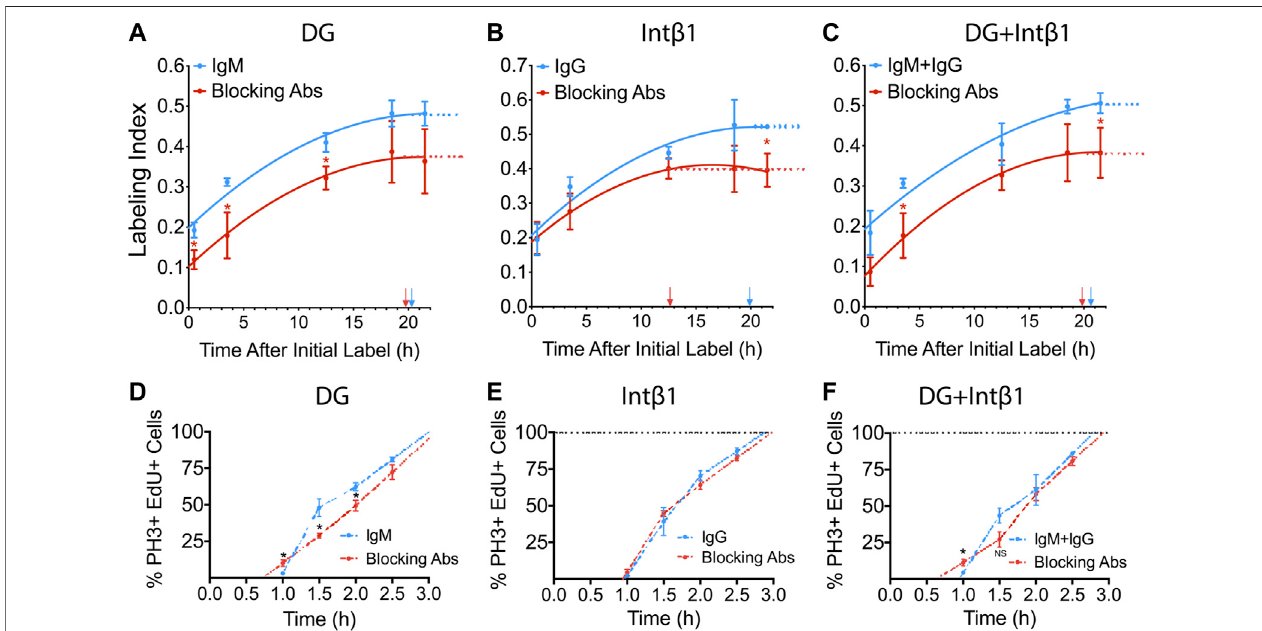
FIGURE 3 | DG and intB1 regulate RPC cell cycle dynamics. (A) . Cumulative S-phase EdU labeling graphs of WT retinal explants with a-DG blocking antibodies. (B) . Cumulative S-phase EdU labeling graphs of WT retinal explants with int β 1 blocking antibodies. (C) . Cumulative S-phase EdU labeling graphs of WT retinal explants with α -DGandint β 1blockingantibodies.ArrowsindicateT C -T S . (D) .LabeledmitosesgraphsforWTretinalexplantswith α -DGblockingantibodies. (E). Labeledmitoses graphs for WT retinal explants with int β 1 blocking antibodies. (F) . Labeled mitoses graphs for WT retinal explants with a-DG and intB1 blocking antibodies. Each data point represents the average of technical and biological experimental replicates ± SEM. Statistical analysis was performed using Student ’ s t-test. * — p ≤ 0.05. NS — not signi fi cant.